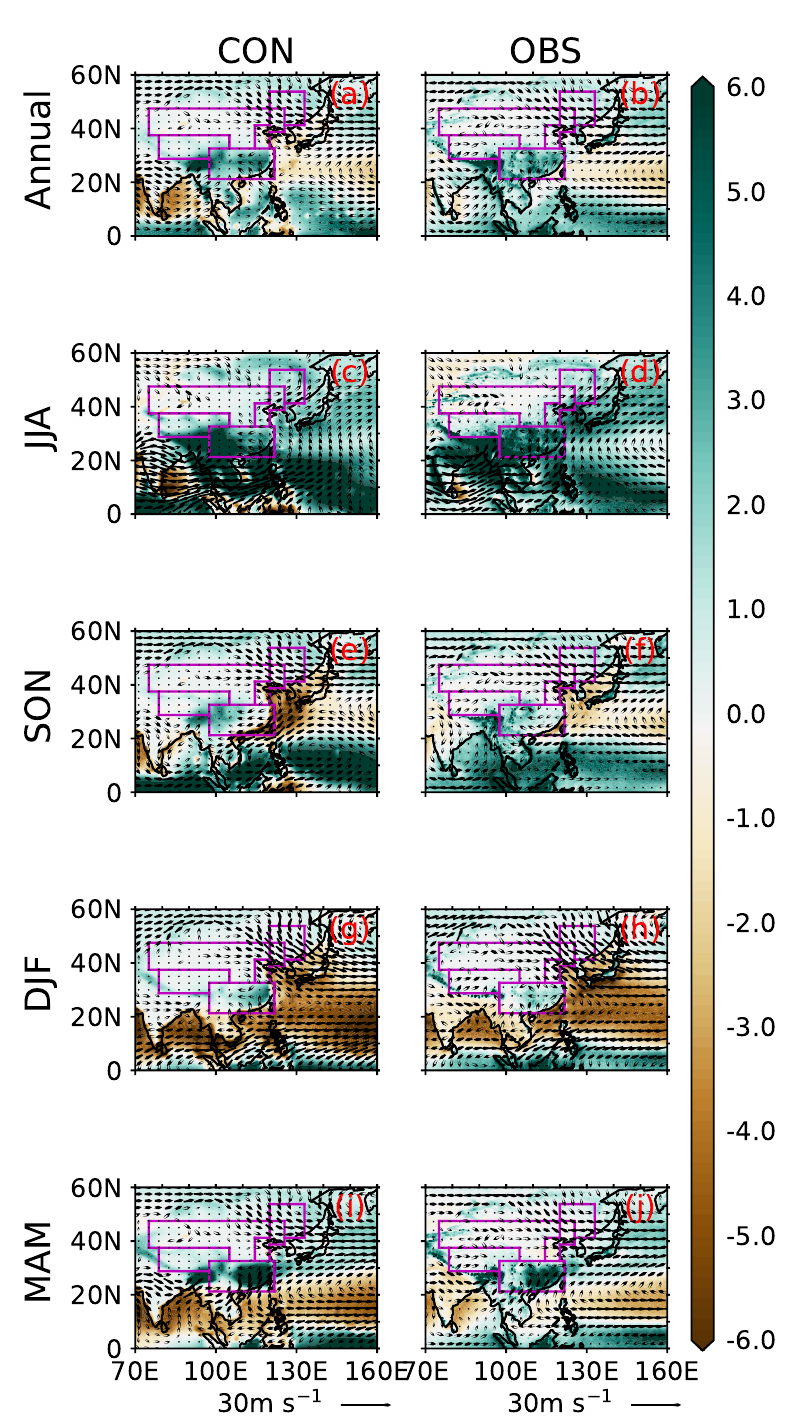
Figure 3. Annual-mean precipitation minus evaporation (mm day − 1 ; shaded) and 850 hPa winds (m s − 1 ; vectors) for ( a ) ensemble-mean control (CON) and ( b ) ERA5 reanalysis (OBS). The same as ( a – b ), seasonal-mean variables are shown for seasons ( c , d ) June–July–August (JJA), ( e , f ) September– October–November (SON), ( g , h ) December–January–February (DJF) and ( i , j ) March–April–May (MAM). The five regions are demarcated by the regional boundaries in